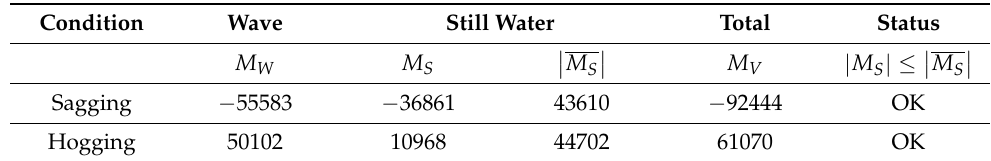
Table 4. Bending moments (tonm units) of the barge calculated considering still water and wave load.